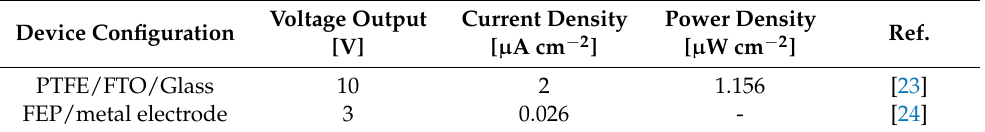
Table 2. Summary of selected electrical properties for triboelectric